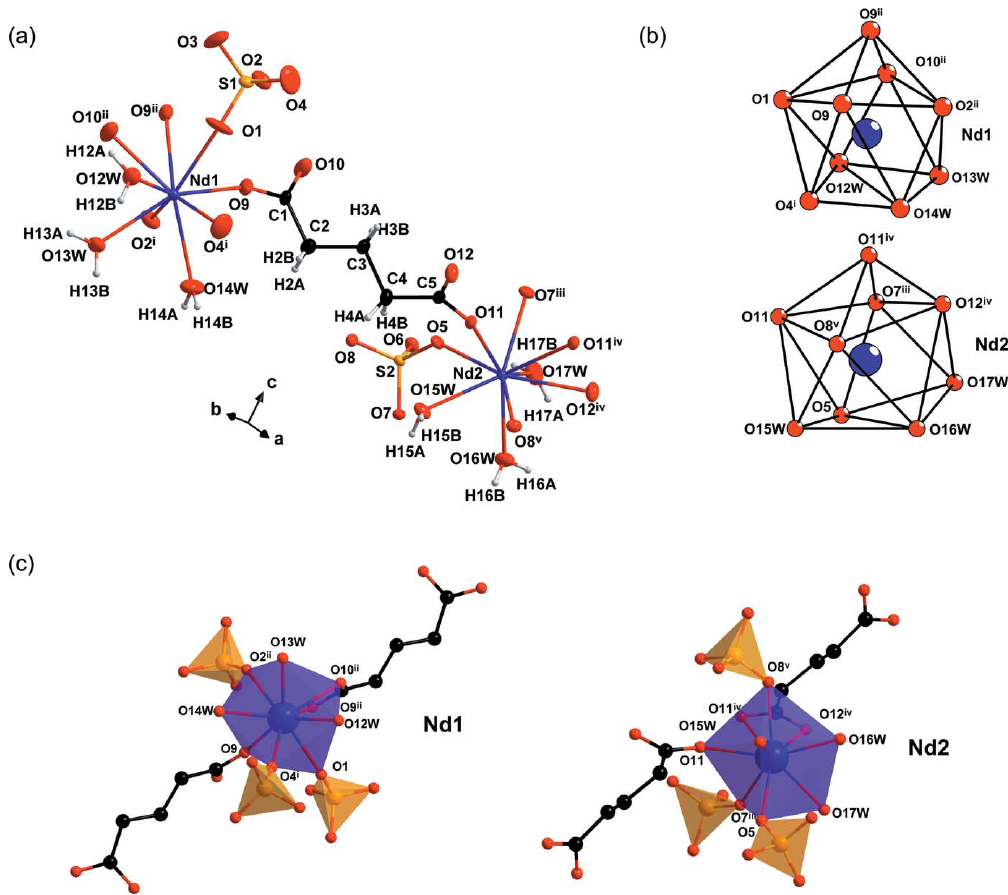
Figure 1 Graphical representations of ( a ) an extended asymmetric unit of 1 drawn with 50% probability ellipsoids, ( b ) coordination geometries of Nd1 (top) and Nd2 (bottom) and ( c ) coordination environment of Nd1 (left) and Nd2 (right). [Symmetry codes: (i) (cid:3) x + 2, (cid:3) y , (cid:3) z ; (ii) (cid:3) x + 2, y - 1/2, (cid:3) z (cid:3) 1 (cid:3) y + 1 , z + 1 ; (iv) (cid:3) x + 1, (cid:3) y + 1, (cid:3) z ; (v) x , (cid:3) y + 1 2 2